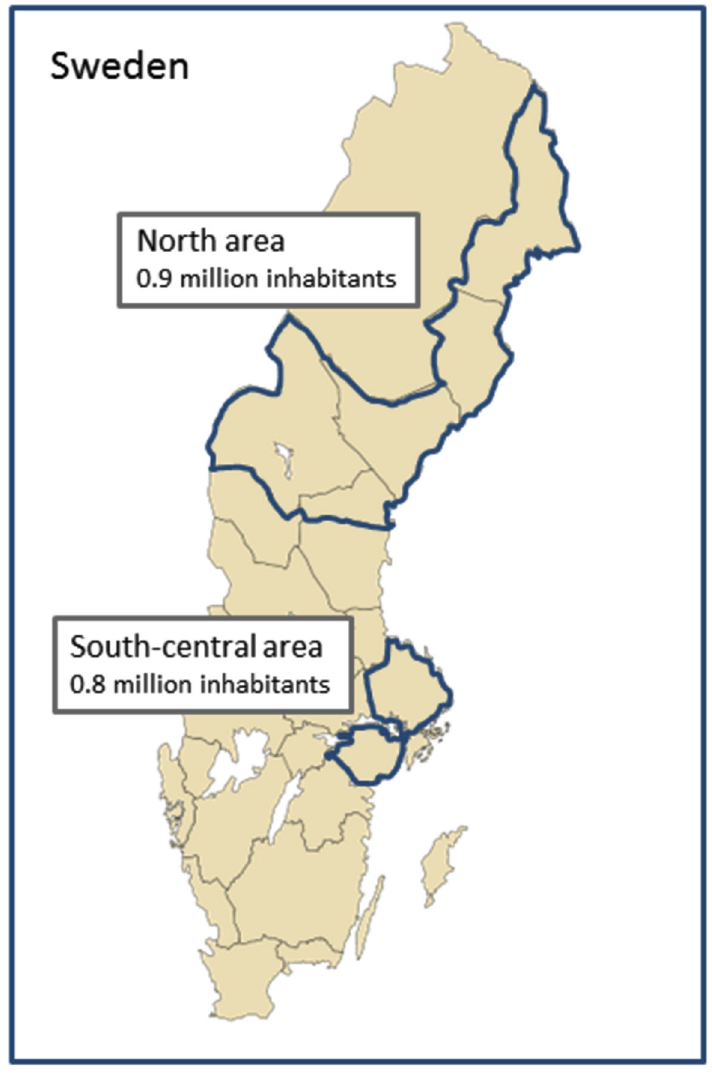
Figure 1. Map of Sweden with the two study